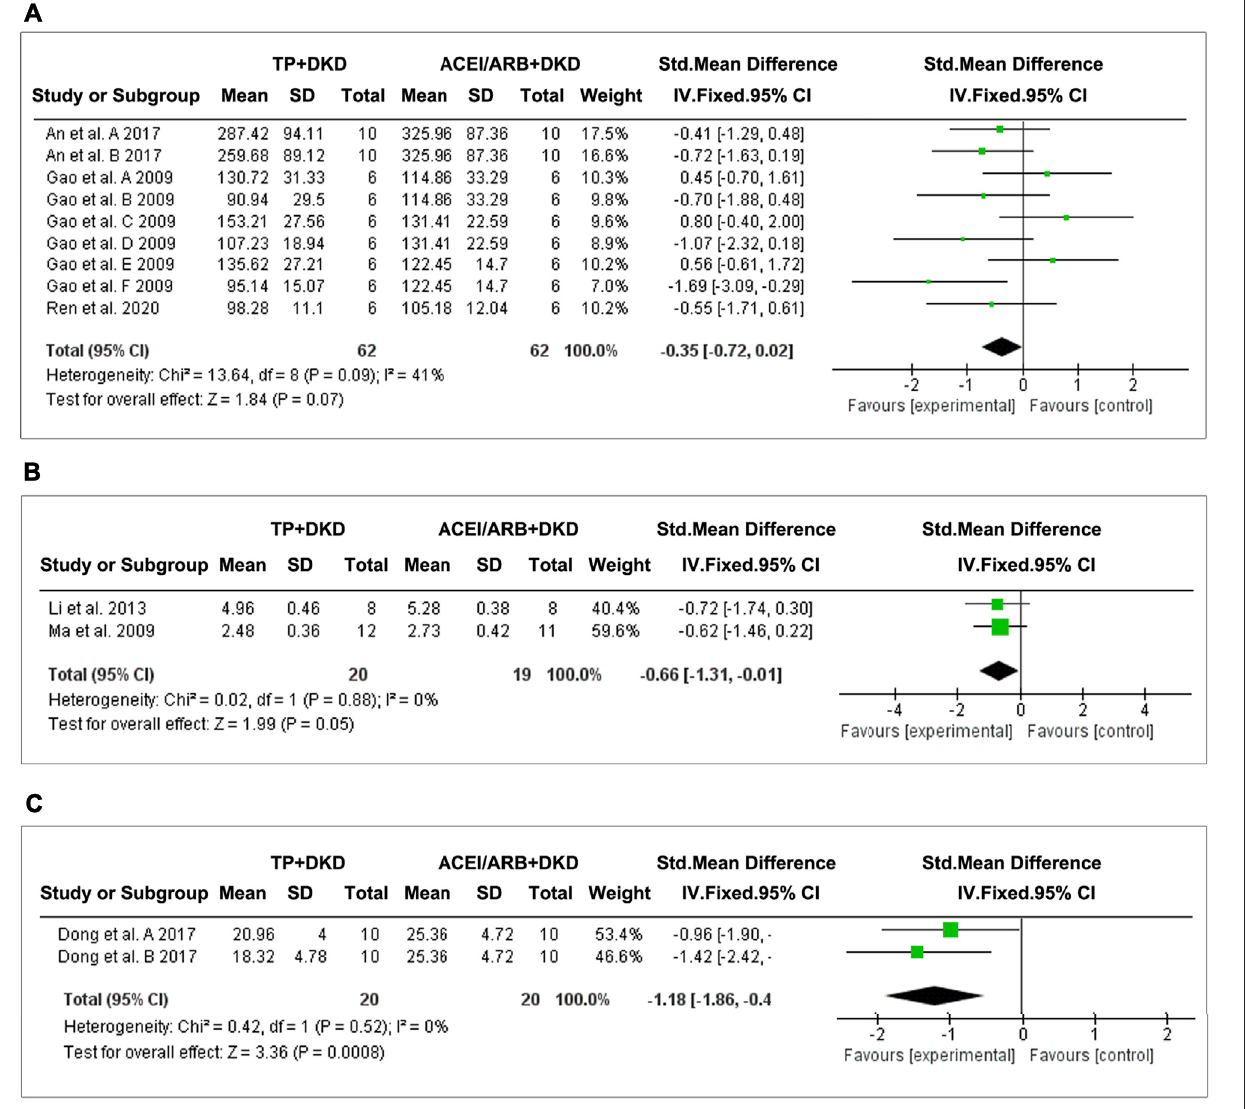
Frontiers in Pharmacology |